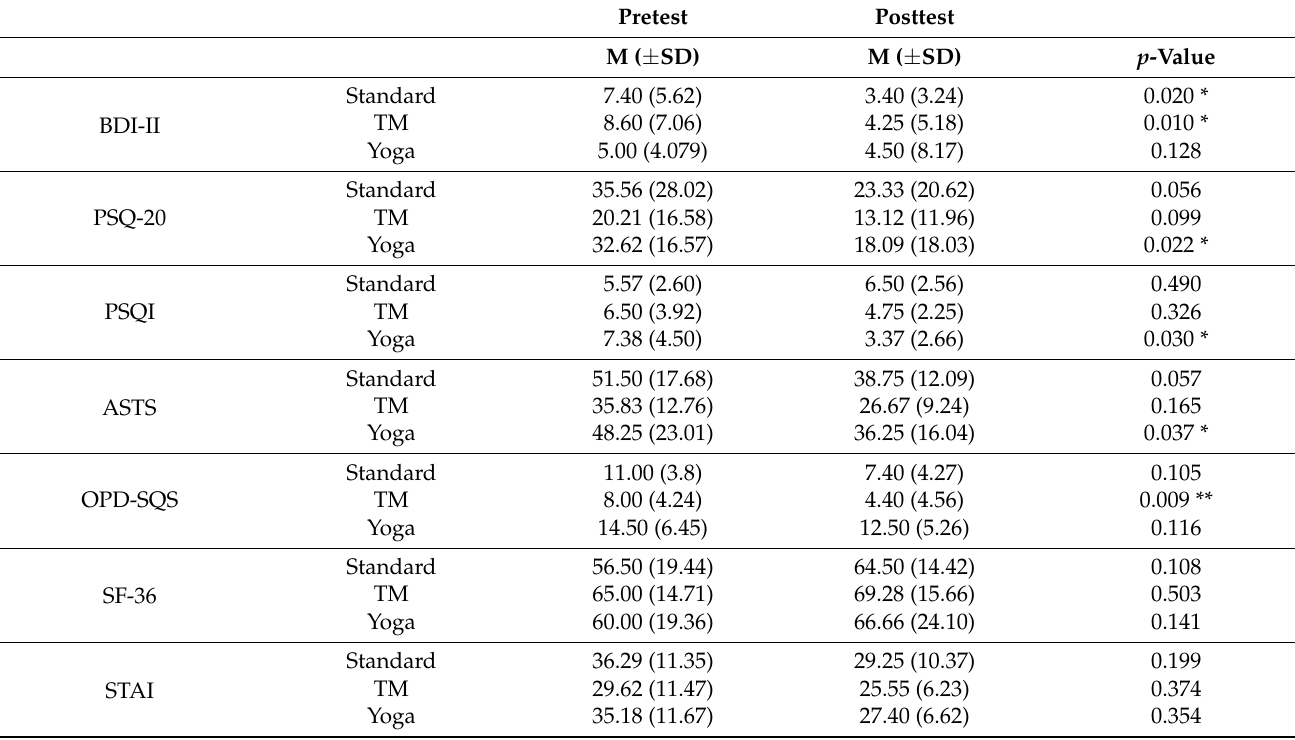
Table 3. Means and standard deviations in psychological variables from pre and post test in the groups (Standard, Yoga,